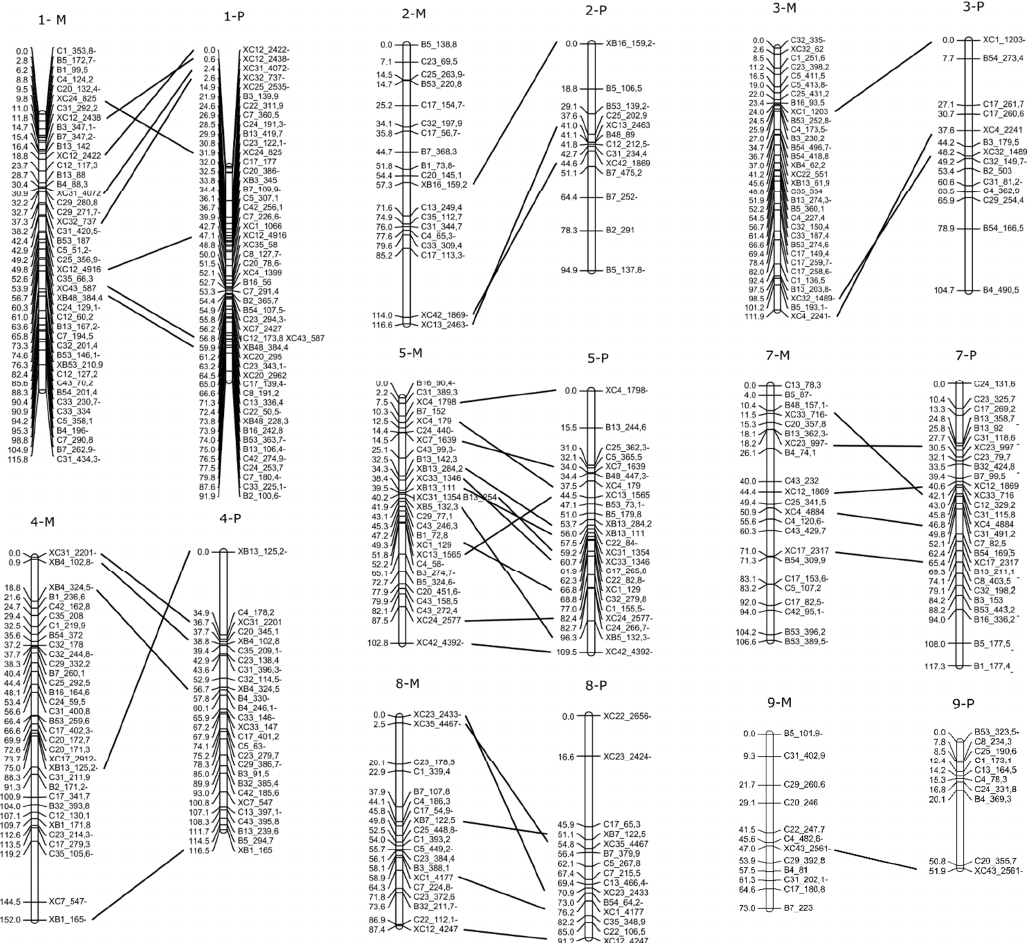
Figure 6. Linkage map of the diploid (2 n = 2 x ) paternal genotype of P. rufum (R5#49). Markers and distances in cM (Kosambi) are indicated on the right and the left respectively. Each co-segregation group includes SDAF and BSDF (starting with an X) markers in coupling and repulsion-phase (-).